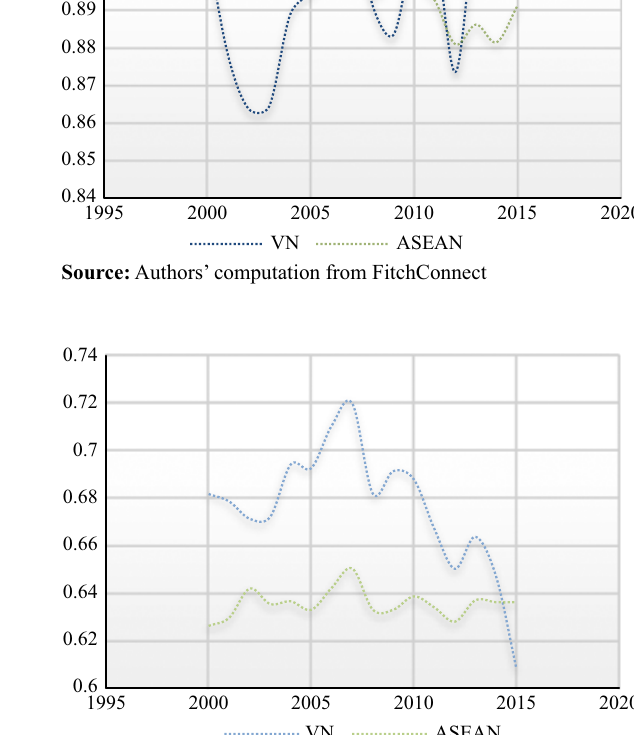
Figure 5. SEMSFA ’ s efficiency without